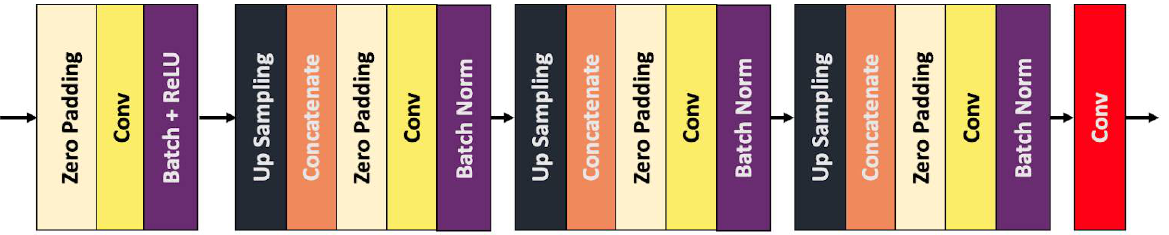
Figure 3. The layers of the proposed U-Net-based decoder.